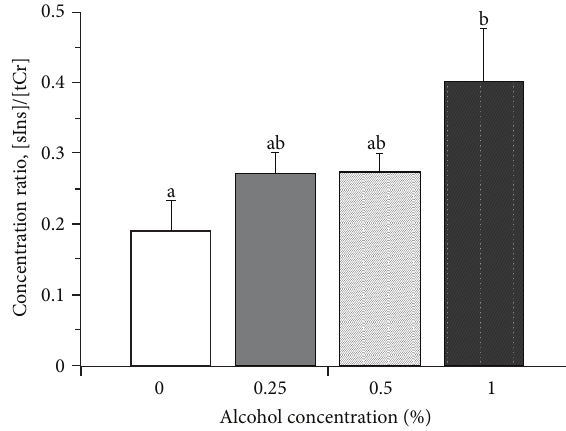
Figure 5: Acute, 1h long, alcohol exposure increases scyllo-inositol to total creatine ratio ([sIns]/[tCr]): mean ± SEM (𝑛 = 10) . Bars not sharing a letter designation are significantly different from each other (𝑃 < 0.05) . Observe the apparent increases in [sIns]/[tCr] but note that only the highest dose group differs significantly from the control